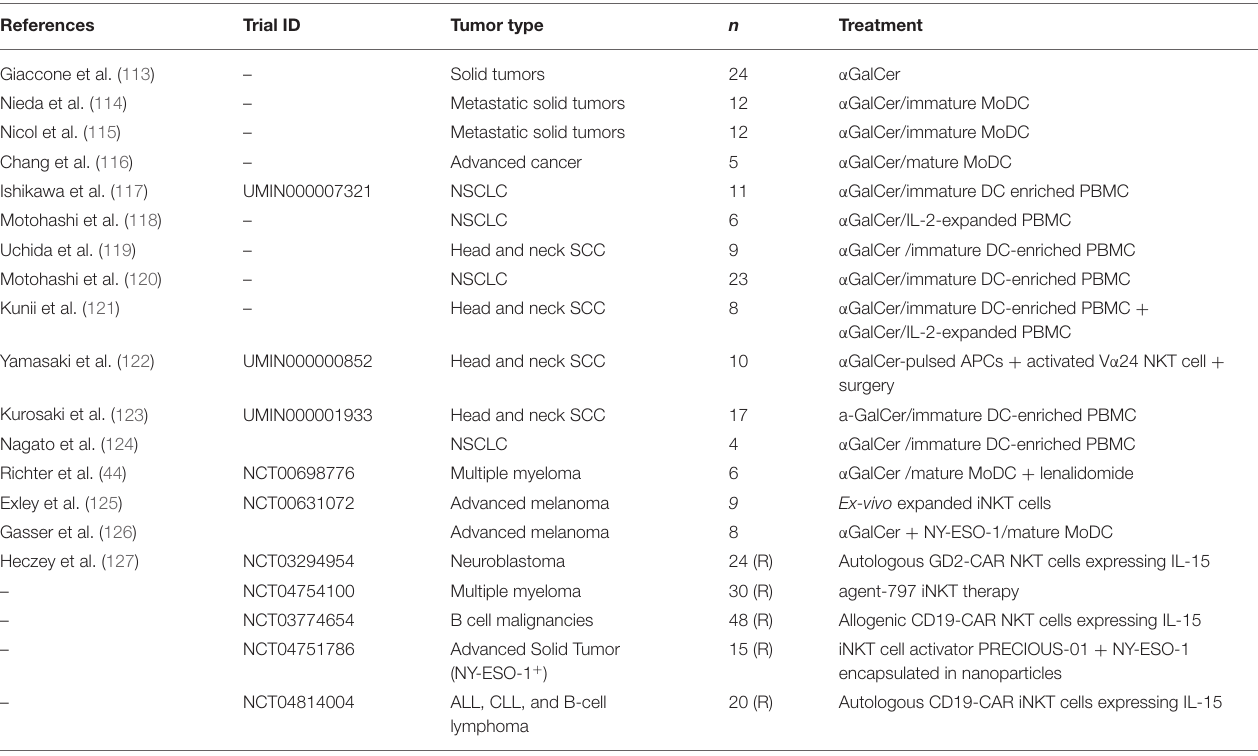
TABLE 2 | iNKT cells used in clinical studies on oncological